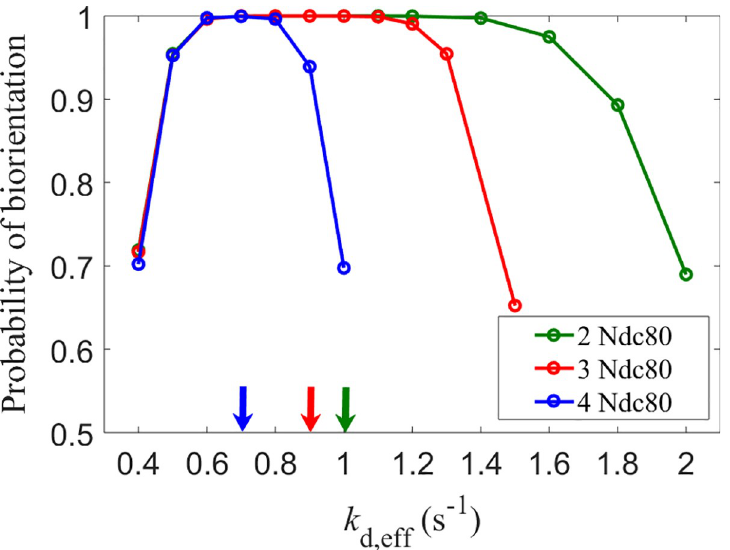
Fig 5. Probability of biorientation in a simplified model. Probability that sister KTs reach biorientation within 10 min, starting from the syntelic attachment state, as a function of an effective MT-Ndc80 dissociation rate ( k d,eff ). Different curves correspond to different numbers of Ndc80s used in the biorientation criterion. The highest value of the probability of biorientation in each case is 1 (or very close to 1). The optimal value of k d,eff , shown with an arrow, was determined using the minimum value of the mean-time for biorientation (S1 Fig in S2 File).